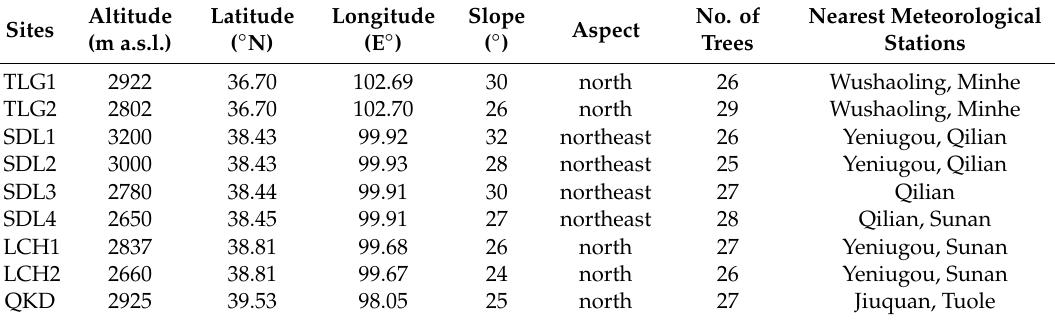
Table 1. Summary of the sampling sites along the gradient of Qilian